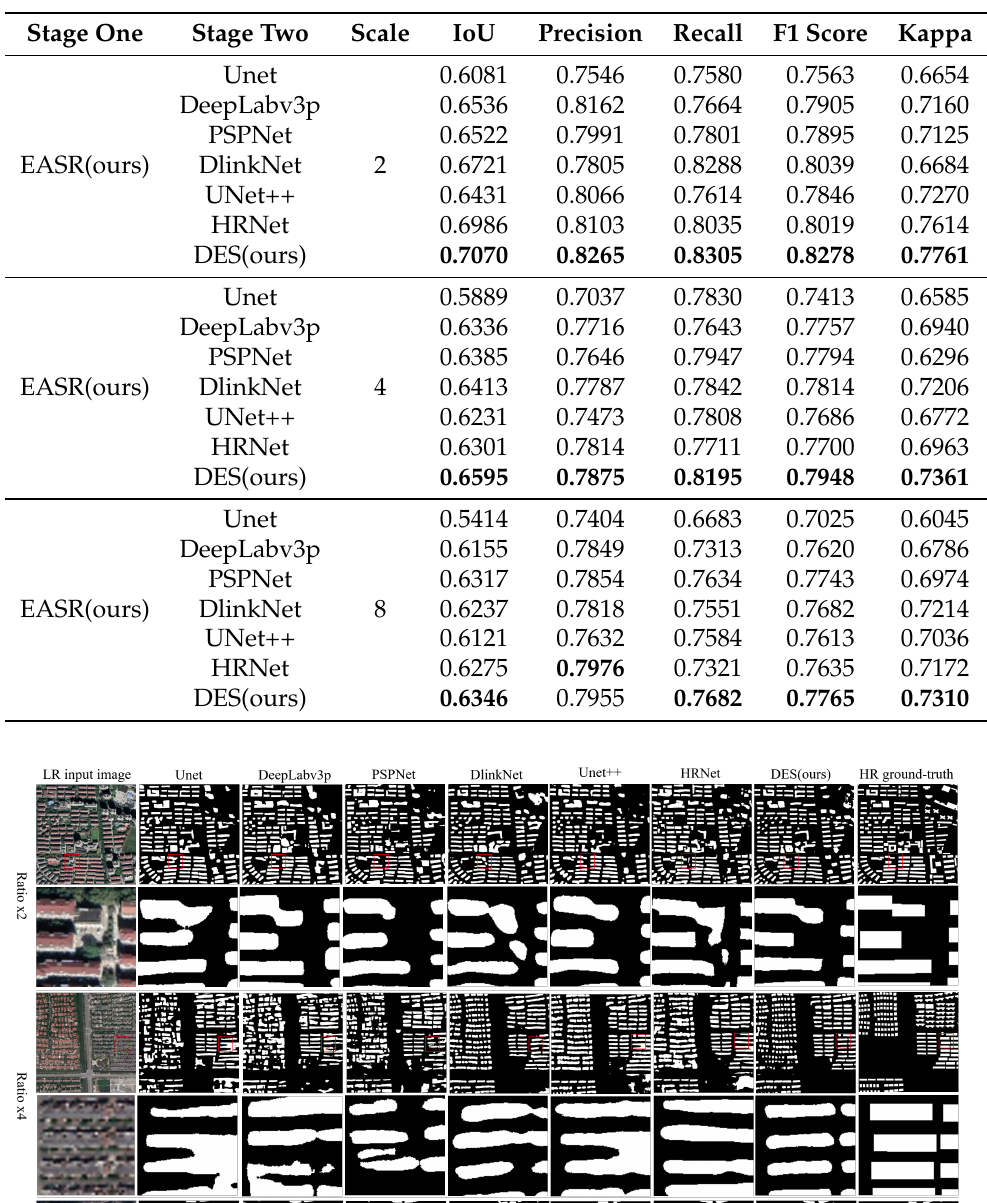
Table 2. Quantitative evaluation results on the segmentation stage.